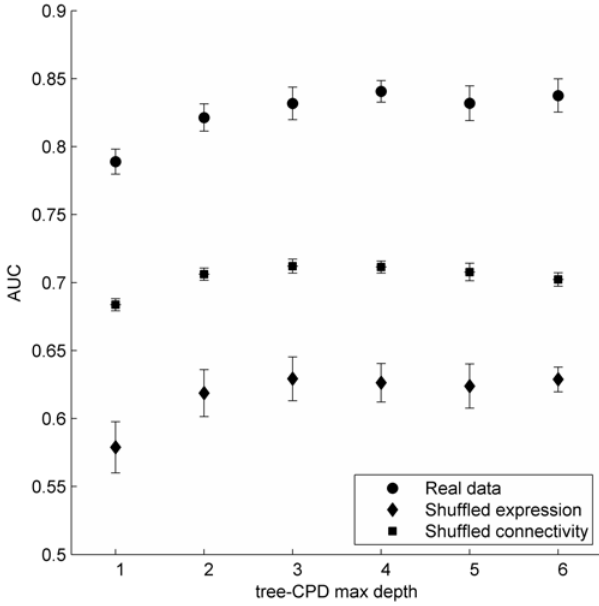
Figure 3. Summary of the Prediction Performance as a Function of the Maximal Depth of the Tree-CPD after 30 AdaBoost Iterations. Standard deviation of the real data was calculated on 50 iterations of 5-fold cross validation, each time for a different division of the data to train and test sets. Standard deviation of the random models was calculated on 50 iterations of 5-fold cross validation, each time for a different shuffling of the data.